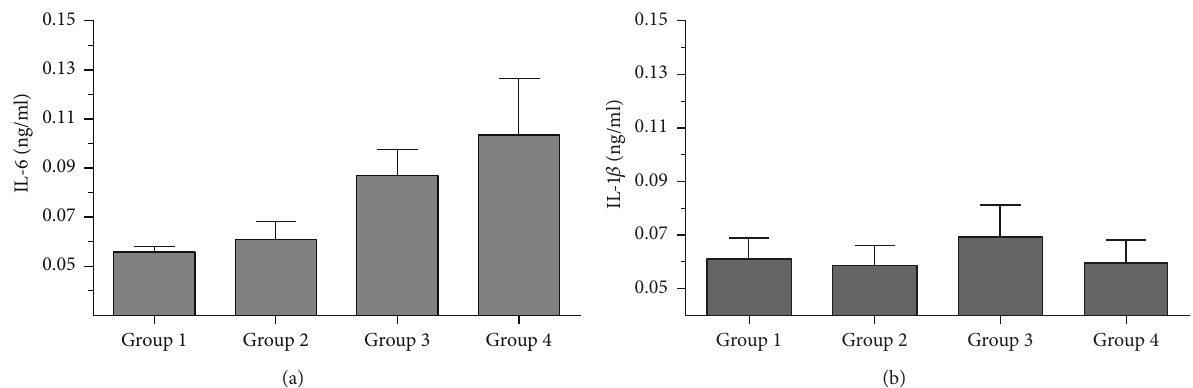
Figure 2: (a) Effect of the inoculation of periodontopathogenic bacteria on serum IL-6 levels. The values shown are the mean of three mice analyzed by study group plus their respective mean. Group 1: untreated sham; Group 2: mice inoculated with Pg/Tf ; Group 3: inoculated intradermally with CFA + Pg/Tf ; and Group 4: CFA inoculated intradermally. These values show a significant increase in IL-6 levels of Group 1 versus Group 2, although a significant difference was not demonstrated ( 𝑝 = 0.128 ) in contrast with Group 3 ( 𝑝 = 0.0262 ). A significant difference was found in Group 1 versus Group 4 ( 𝑝 = 0.0555 ). (b) Effect of the inoculation of periodontopathogenic bacteria on serum levels of IL-1 𝛽 . Murine blood was drawn on day 35 after euthanasia and was centrifuged and analyzed the next day. IL-1 𝛽 in the supernatant was determined by ELISA. Groups: 1, 2, 3, 4. Bars represent the mean ± standard deviation of three replicates from three animals per group; these did not show statistically significant increases. PRISM v.6.0 was used for data analysis.